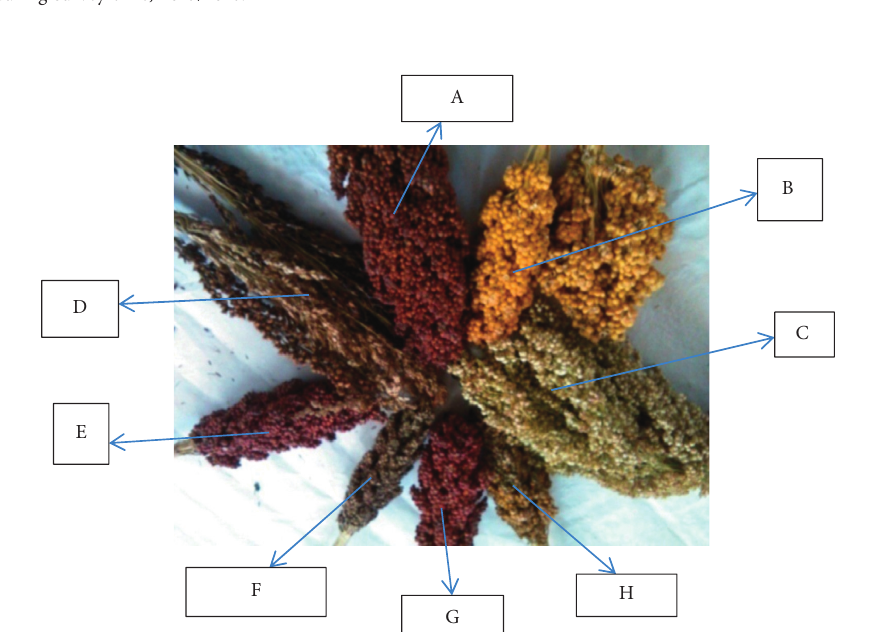
Figure 2: Sample representatives of sorghum landraces: Zengada (A), Wetere (B), Necho-Tinkish (C), Jofa-Tinkish (D), Nech-Mashila (H, F), and Key-Gedalit (E, G) in Tenta, Mekdela, and Delanta districts. Source: local farmers during survey time, 2015/2016.